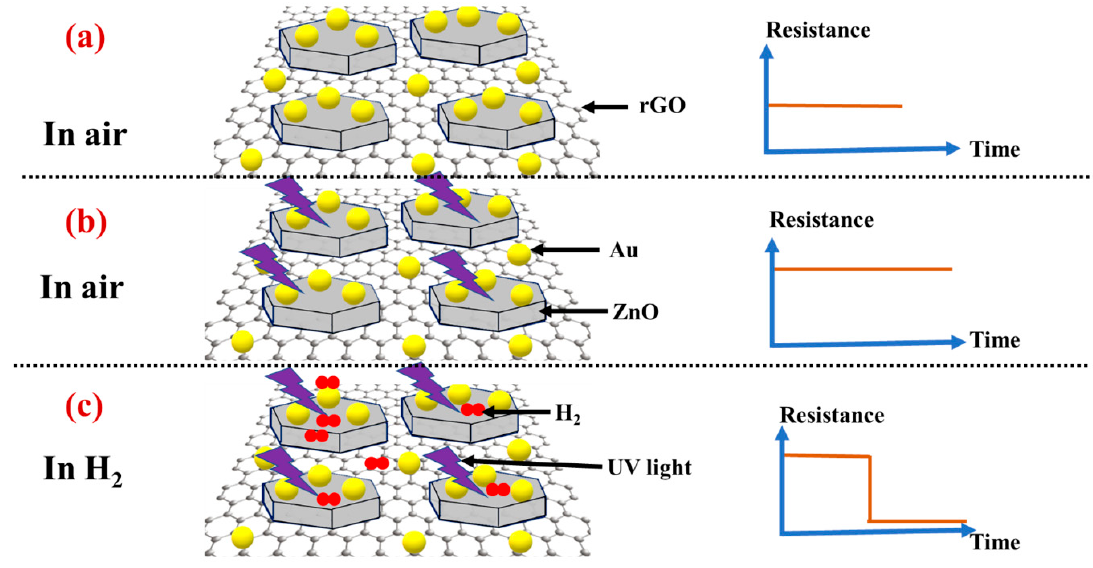
Figure 12. Gas sensing mechanism of Au / rGO / ZnO sensor in ( a ) air ( b ) air with UV light, and ( c ) H 2 environment with UV irradiation [128]. Copyright (2020), with permission from Elsevier.